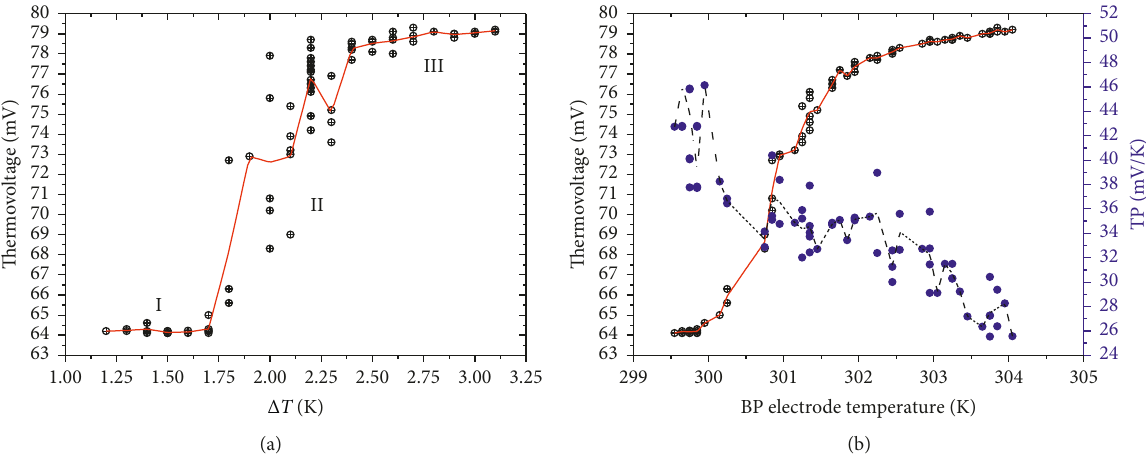
Figure 5: Temperature dependence of voltage (a) and thermoelectric power of the thermocell (b). The values were extracted from device under room temperature and heating with infrared